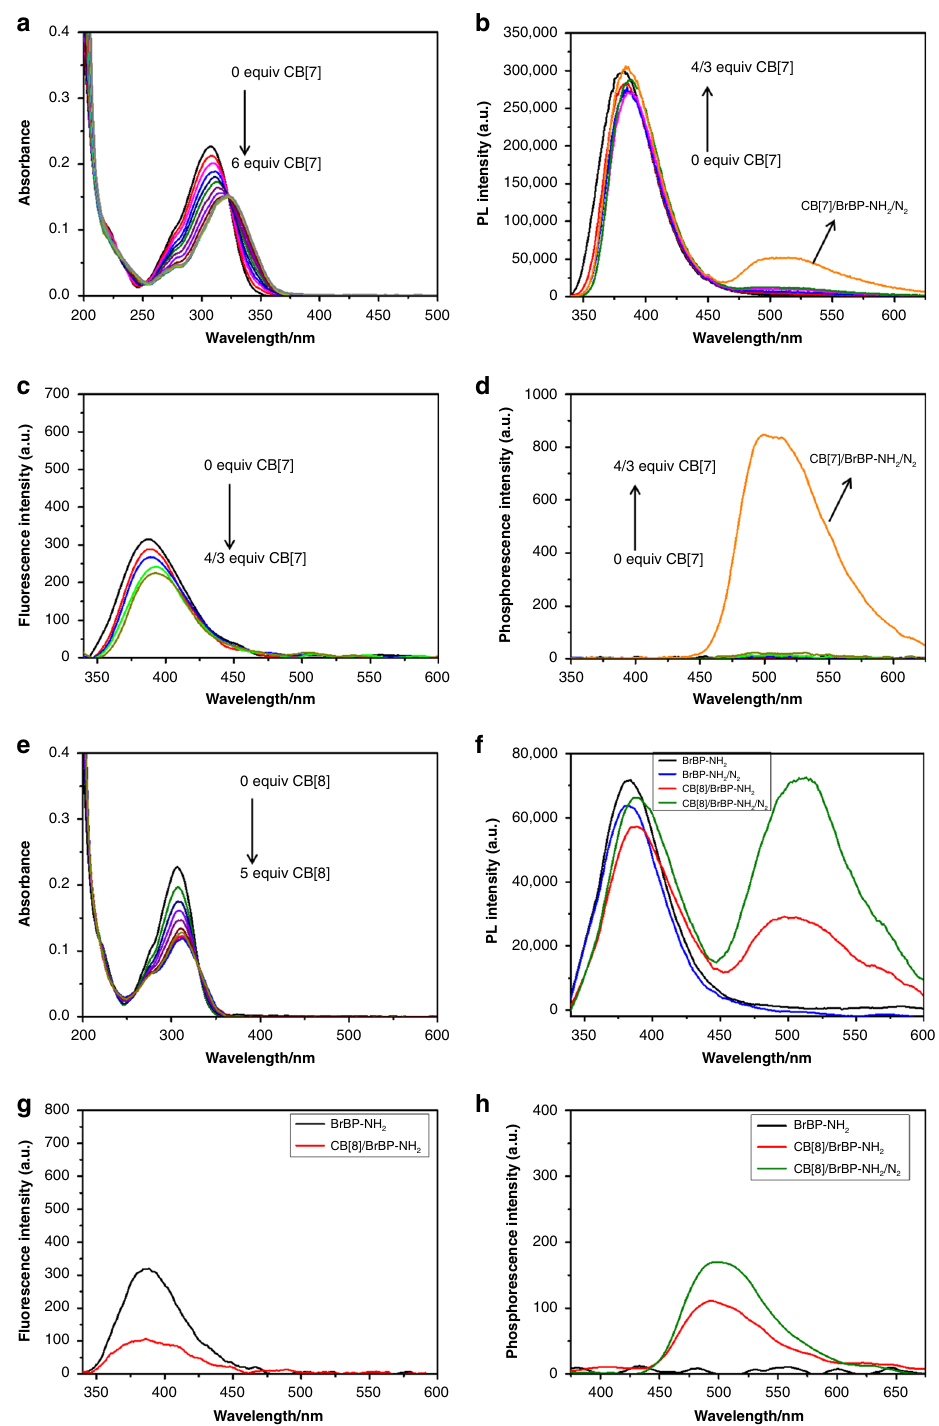
Fig. 2 Effect of complexation with CB[7] and CB[8] on the spectra of BrBP – NH 2 . a Absorption spectra of BrBP – NH 2 (0.01 mM) in the absence (black) and presence (yellow) of CB[7] (0.06 mM) in water at 25 °C. b Prompt photoluminescence spectra, c fl uorescence spectra, and d phosphorescence spectra (delayed by 0.2 ms, Ex. Slit = 10 nm, Em. Slit = 10 nm) of BrBP – NH 2 (black), CB[7]/BrBP – NH 2 (yellow), and CB[7]/BrBP – NH 2 /N 2 (orange) ([BrBP – NH 2 ] = 0.5 mM, [CB[7]] = 0.67 mM) in water at 25 °C ( λ ex = 320 nm). e Absorption spectra of BrBP – NH 2 (0.01 mM) in the absence (black) and presence (red) of CB[8] (0.05 mM) in water at 25 °C. f Prompt photoluminescence spectra, g fl uorescence spectra, and ( h ) phosphorescence spectra (delayed by 0.2 ms, Ex. Slit = 5 nm, Em. Slit = 5 nm) of BrBP – NH 2 (black), CB[8]/BrBP – NH 2 (red), and CB[8]/BrBP – NH 2 /N 2 (green) ([BrBP – NH 2 ] = 0.5 mM, [CB[8]] = 0.25 mM) in water at 25 °C ( λ ex = 320